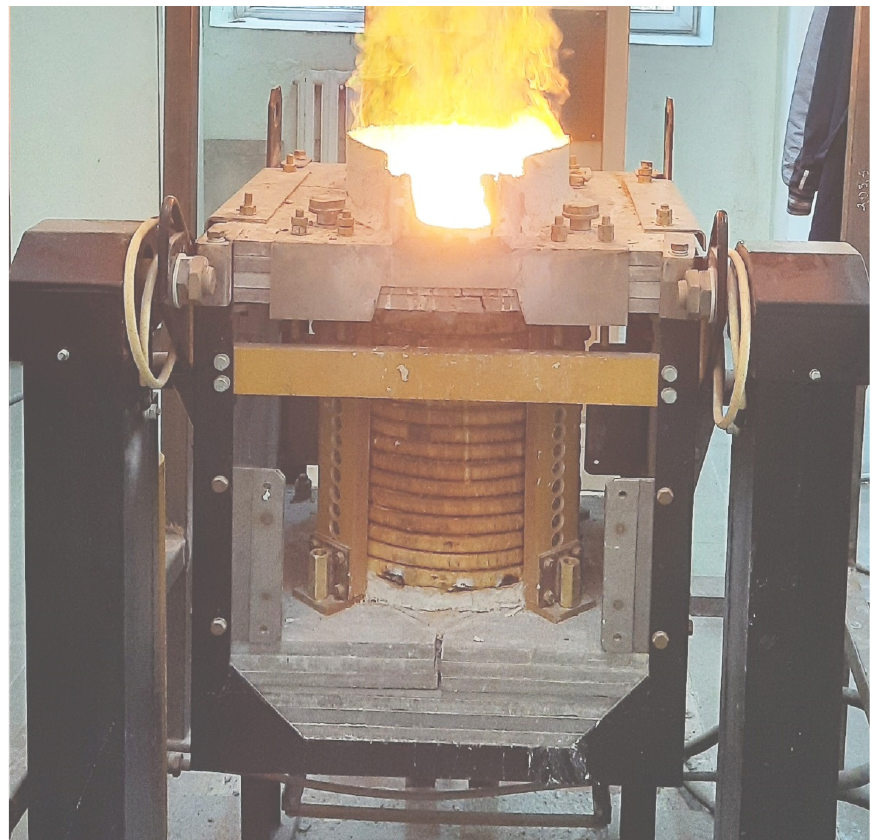
Figure 1. The “Parallel” induction furnace during slag refining process.